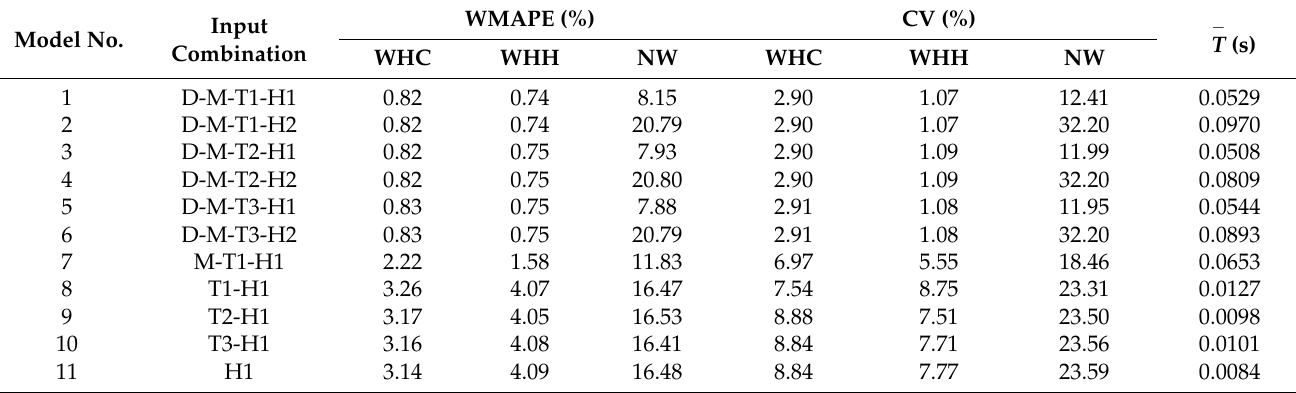
Table 8. Test results for lighting-plug system in different schedule input patterns in Case